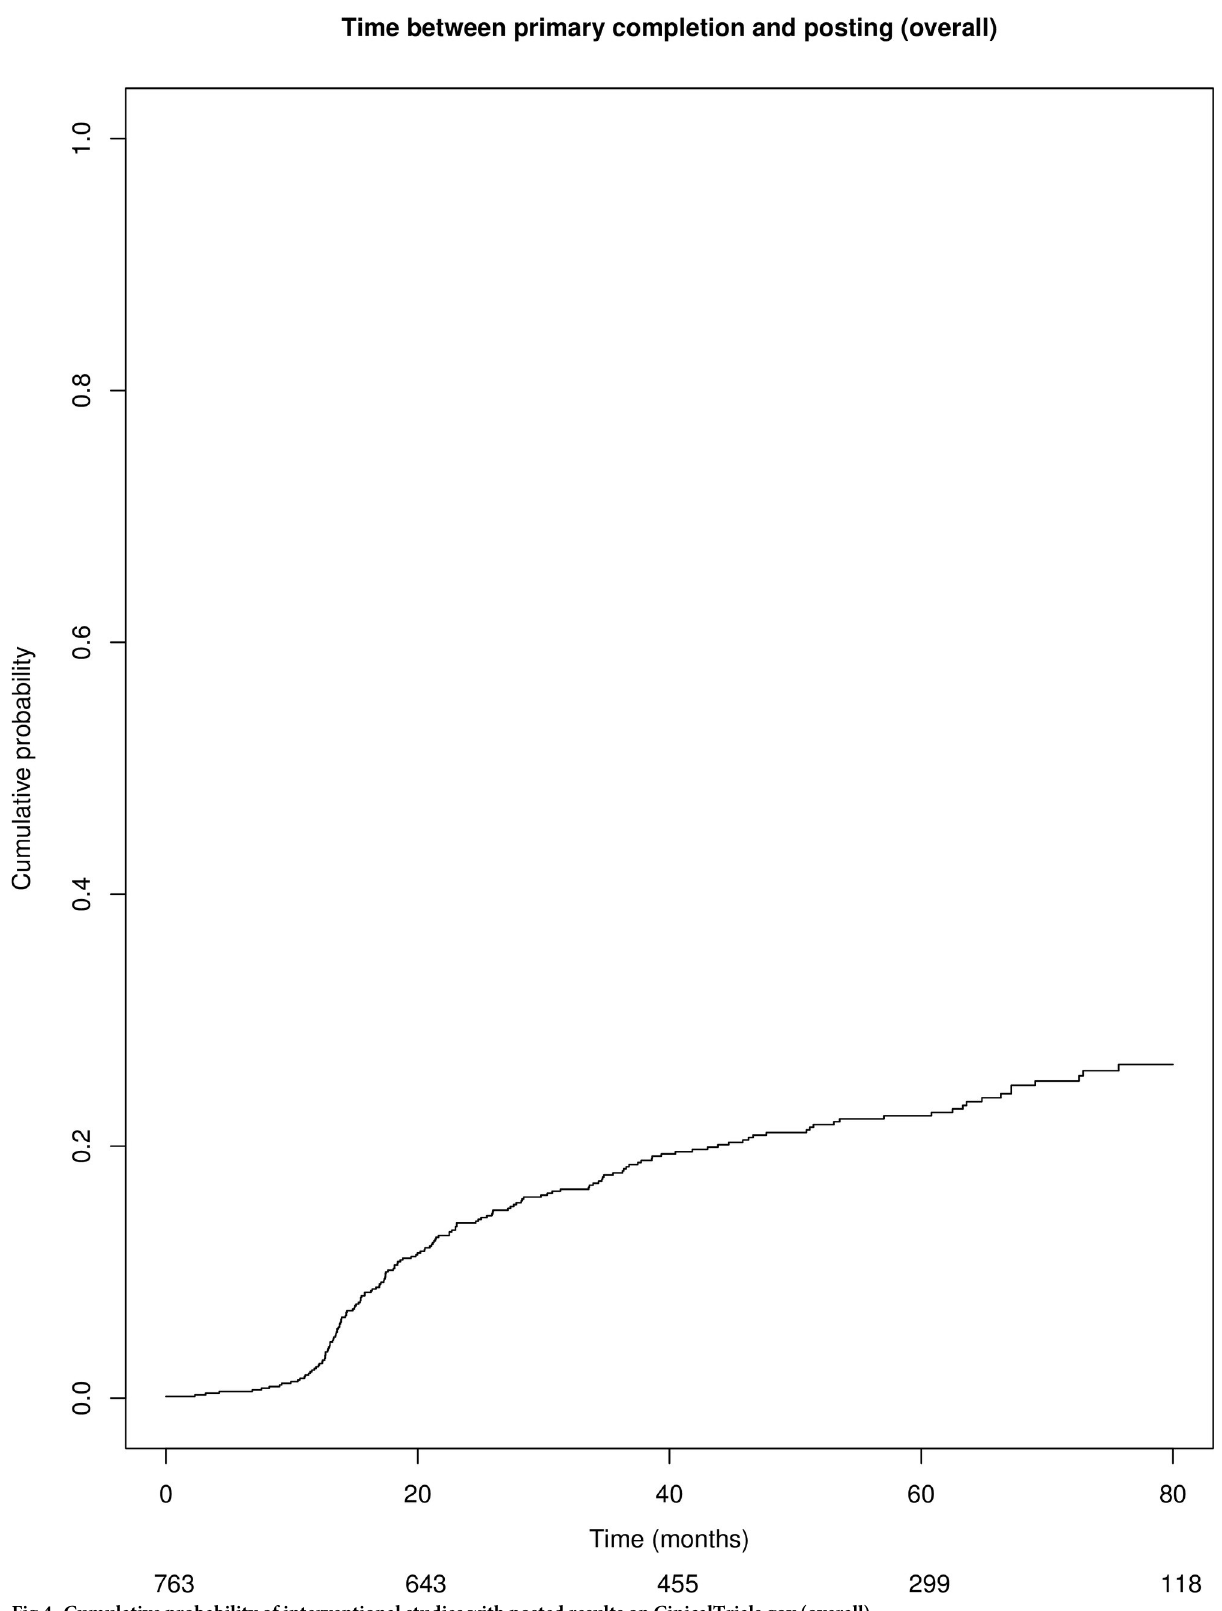
Fig 4. Cumulative probability of interventional studies with posted results on CinicalTrials.gov (overall). https://doi.org/10.1371/journal.pone.0266496.g004 PLOS ONE | https://doi.org/10.1371/journal.pone.0266496 April 11,